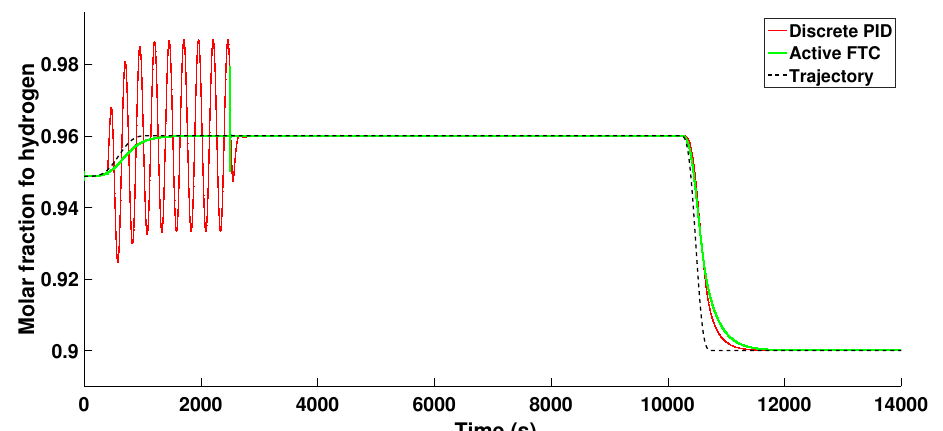
Figure 16. Scenario 1 − Sine wave-type fault: Comparison between the discrete PID controller and the FTC applied to the reduced model (Hammerstein − Wiener) for controlling the hydrogen purity with trajectory changes and sine wave-type fault.